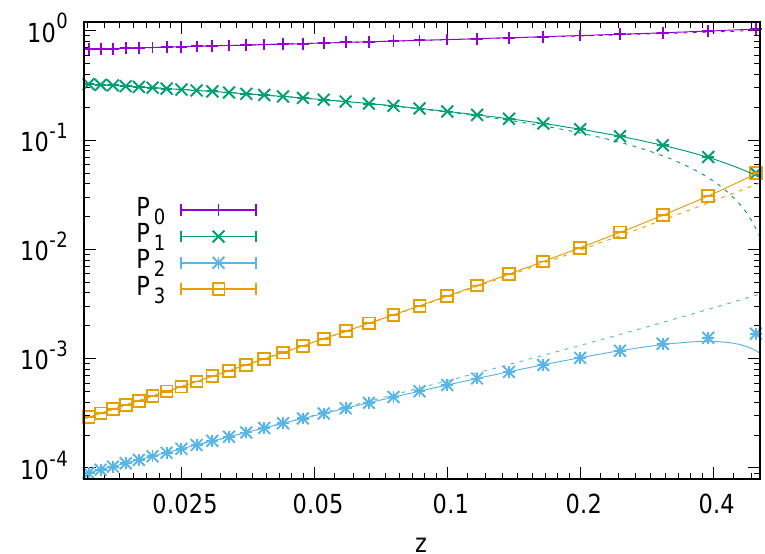
Figure 3.5: Monte-Carlo data for P (cid:27) ( z ) as a function of z for Q = 1. We also plot the best fits of the type (67) with K = 1 term (dashed lines) and K = 2 terms (thin lines).